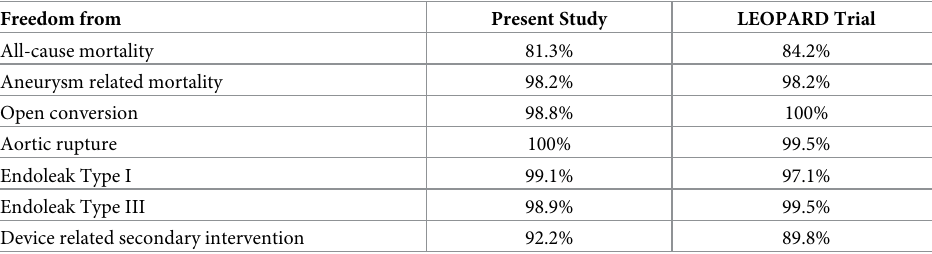
Table 3. Freedom from adverse events.